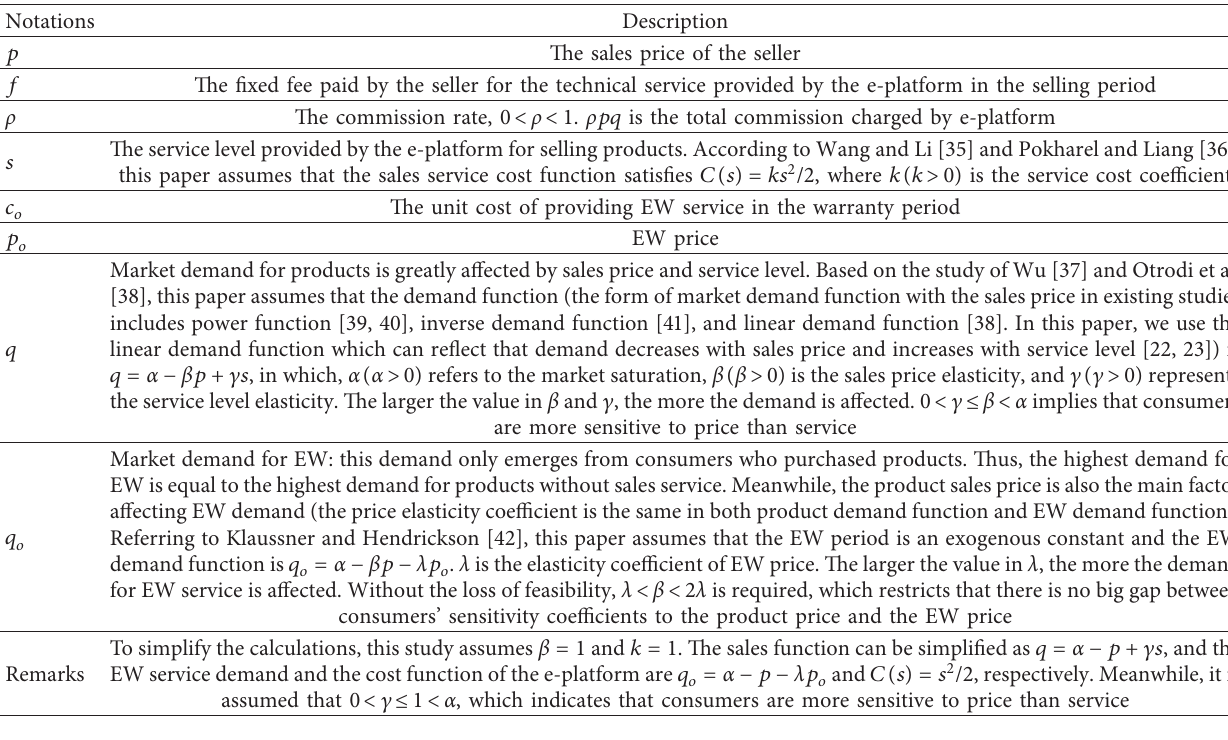
Table 2: Description of notations.